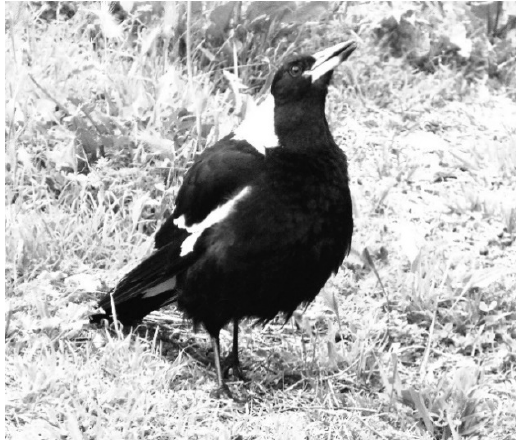
Figure 5. Male beginning to carol: typical posture seconds before the onset of carolling. Note the raised and ruffled looking feathers particularly on the upper and lower breast and belly indicating muscle involvement in a call that may take a good deal of energy, and a second before, the head is thrown back and the beak opened wide.